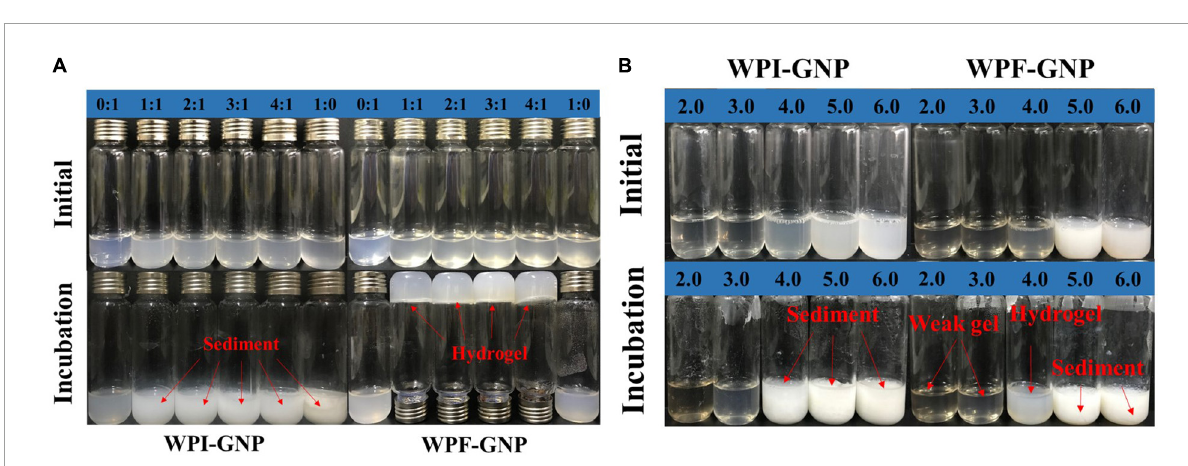
FIGURE2 (A) Visual appearances of WPI-GNP hybrid and WPF-GNP hydrogel at various ratio and pH 4.0 before and after incubation at 85 ◦ C for 3 h; (B) The influence of pH values on the WPI-GNP hybrids (WPI: GNP = 4:1) and WPF-GNP hydrogel (WPF: GNP = 4:1) before and after incubation at 85 ◦ C for 3